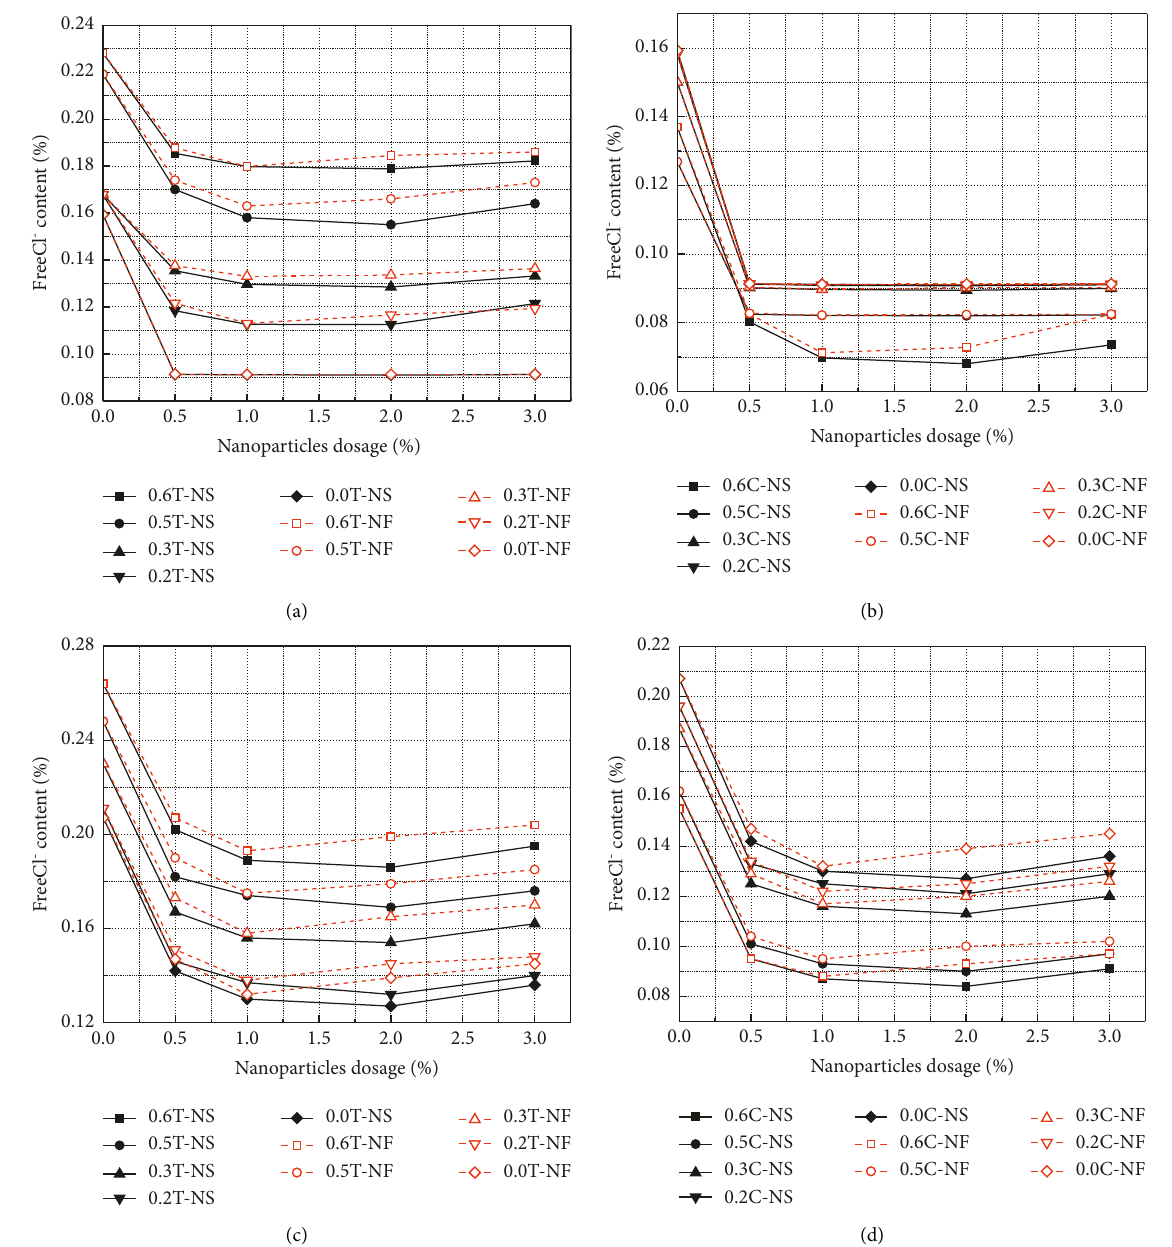
Figure 8: (a) Tensile zone (3–5mm, 7 d). (b) Compressive zone (3–5mm, 7d). (c) Tensile zone (3–5mm, 30d). (d) Compressive zone (3-5mm,